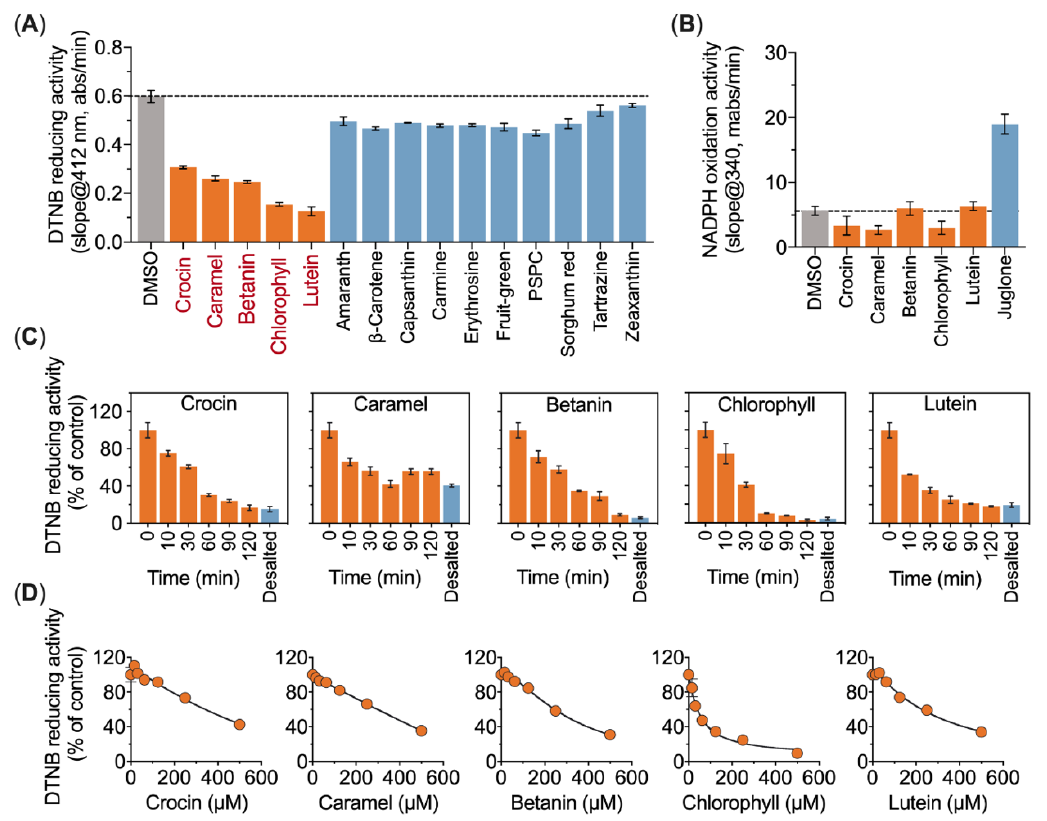
Figure 2. Food colorants inhibit TrxR1 activity. ( A ) Food colorants inhibit the DTNB reducing activity of TrxR1. TrxR1 was pre-reduced by 100 µ M NADPH for 10 min and incubated with various food colorants (500 µ M) for 30 min in dark. Subsequently, the enzyme activity was determined by DTNB reducing assay. ( B ) NADPH consumption of TrxR1 with 30 µ M selected food colorants. Juglone was used as the positive control. ( C ) Time-dependent inhibition of TrxR1 by food colorants. NADPH pre-reduced TrxR1 was incubated with 500 µ M food colorants, and the enzyme activity was determined at indicated times. After incubation for 2 h, the enzyme was desalted using a NAP-5 TM column. ( D ) Dose-dependent inhibition of selected food colorants on TrxR1 mediated DTNB